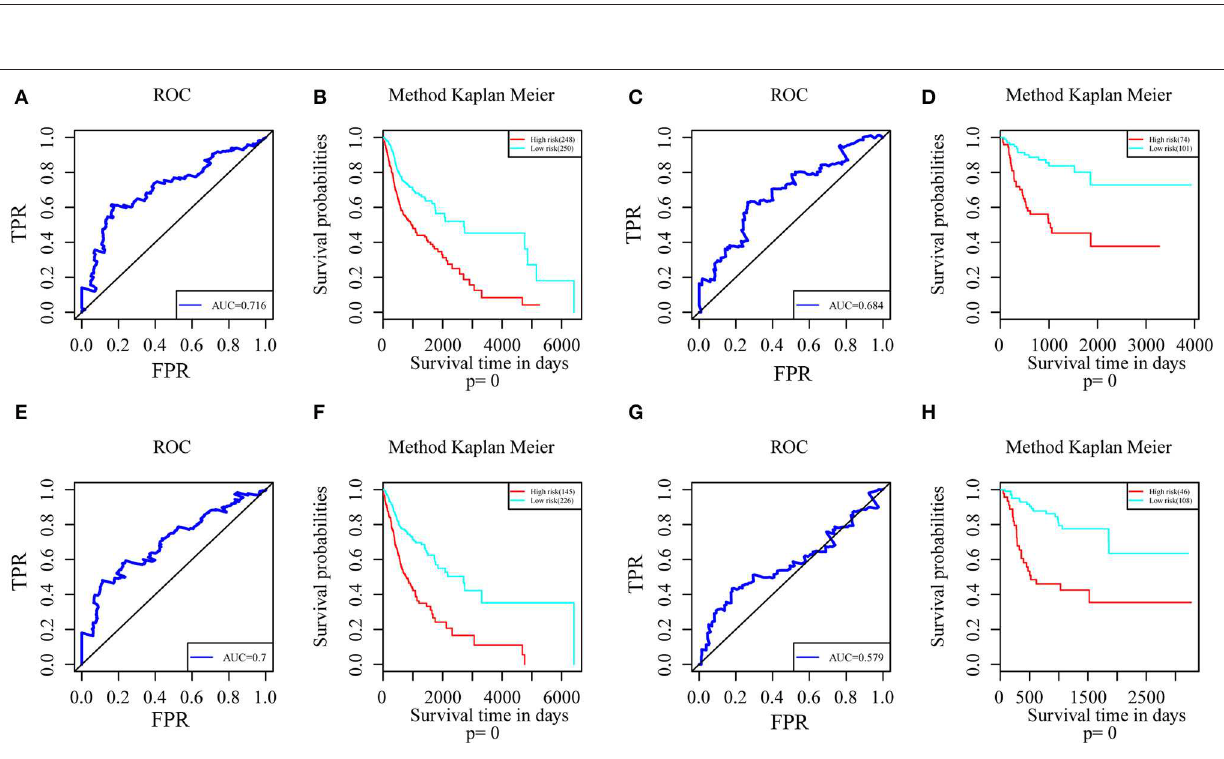
Frontiers in Oncology |